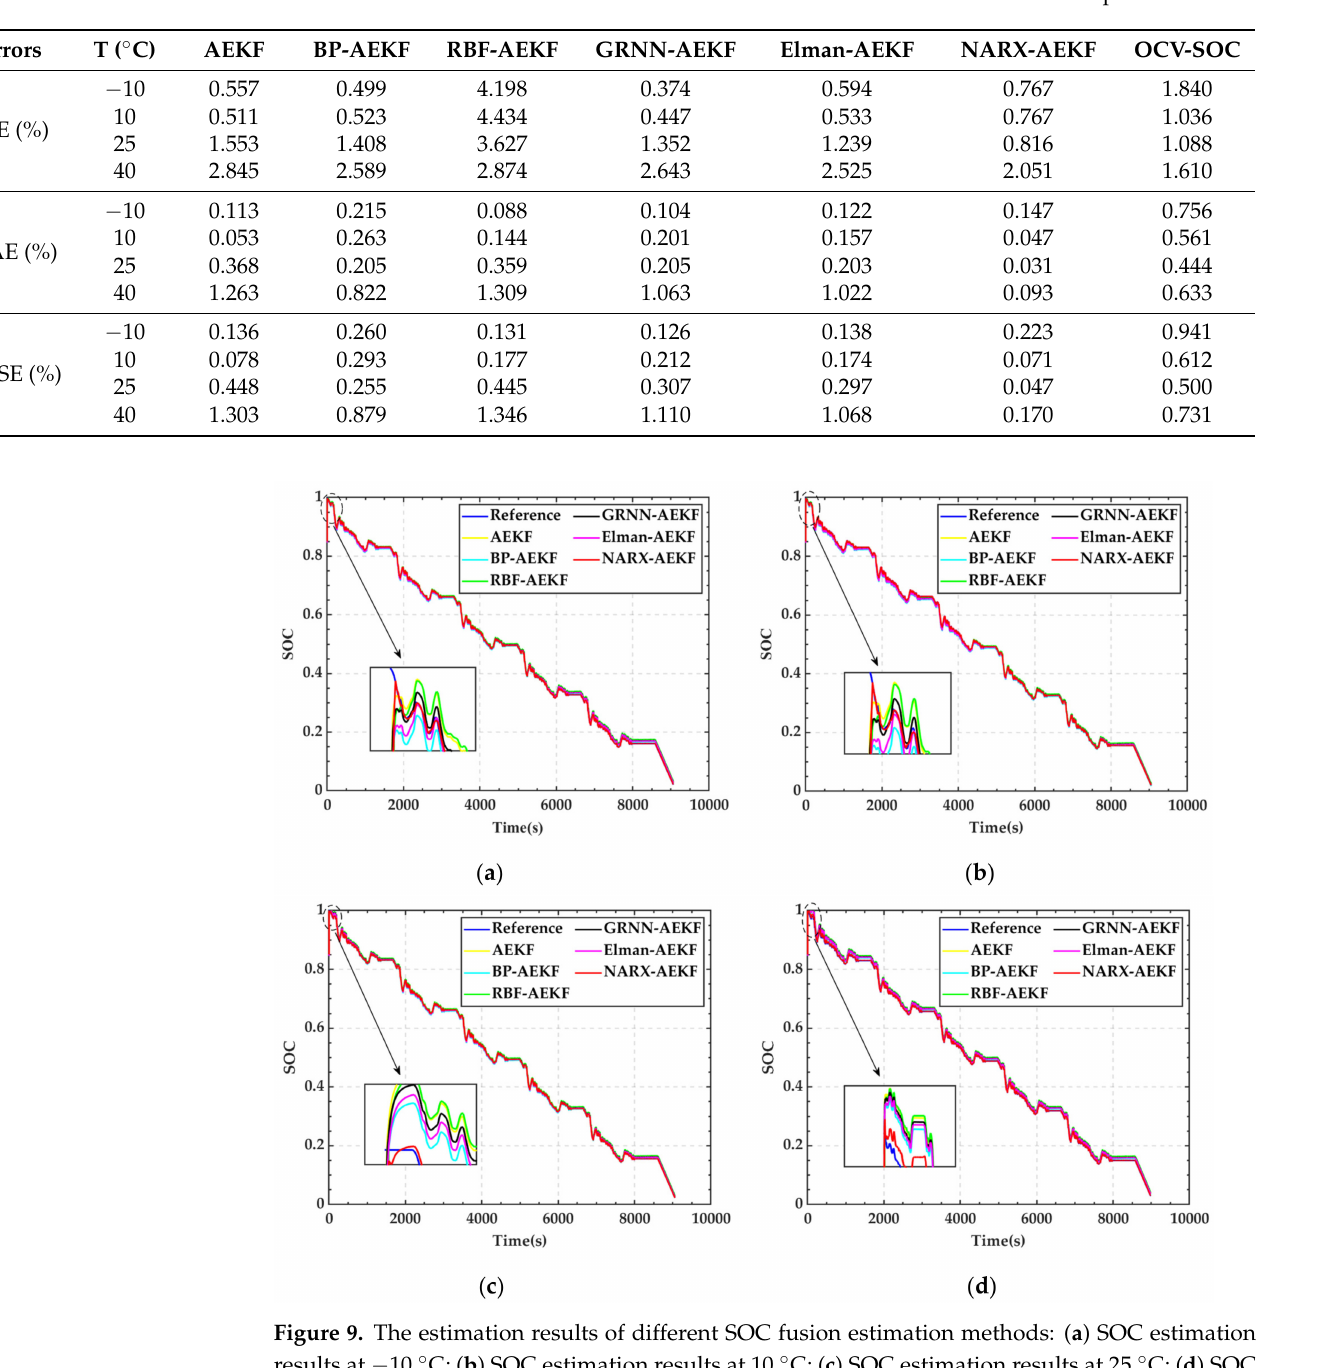
Table 6. The SOC estimation statistical errors for the seven methods at different temperatures.